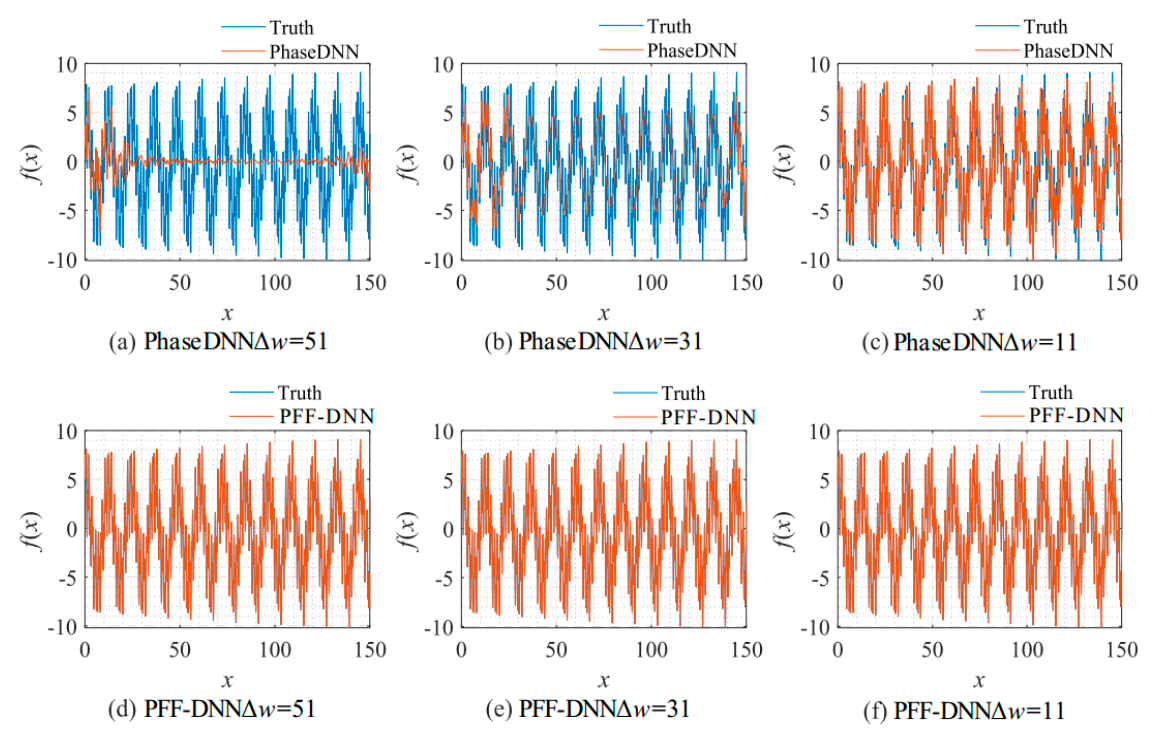
Figure 12. The influence of Δ ω on the algorithm performance. The fitting results of the PhaseDNN method after 10,000 updates: ( a ) Δ ω = 51; ( b ) Δ ω = 31; ( c ) Δ ω = 11. The fitting results of the PFF-DNN